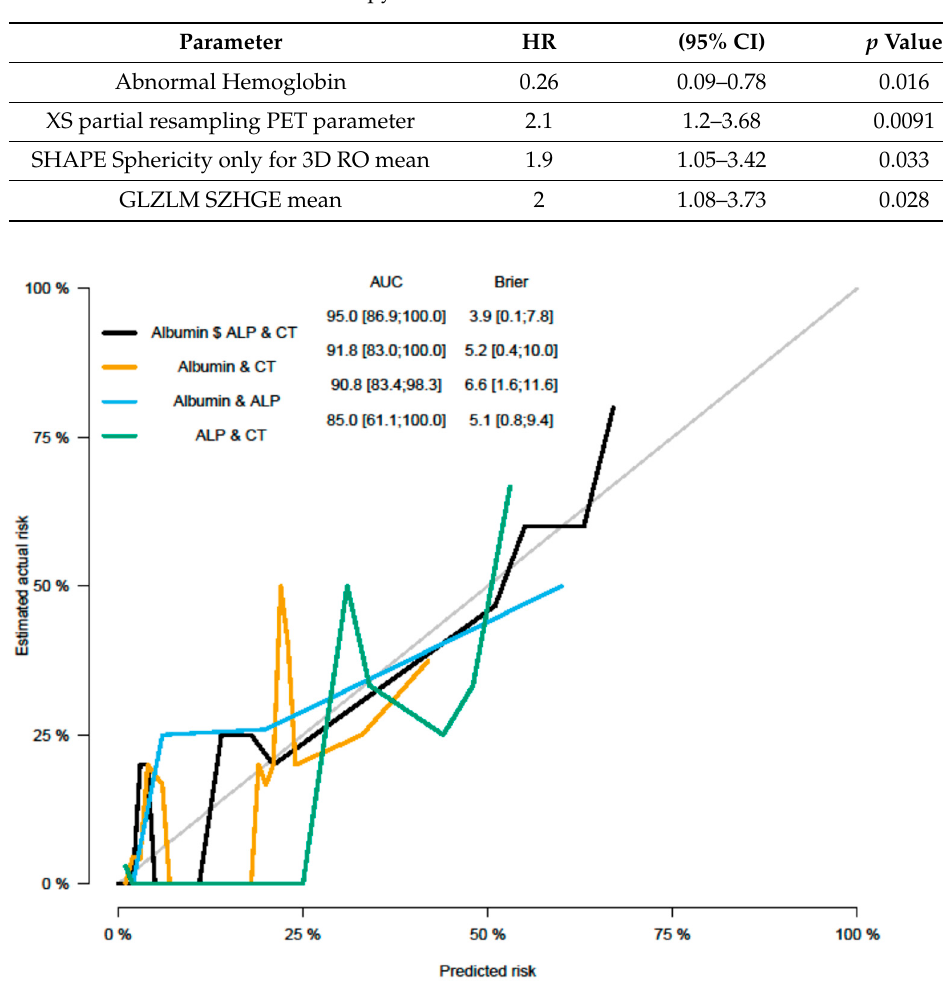
Figure 2. Calibration plots and AUC considering different variables in the model.